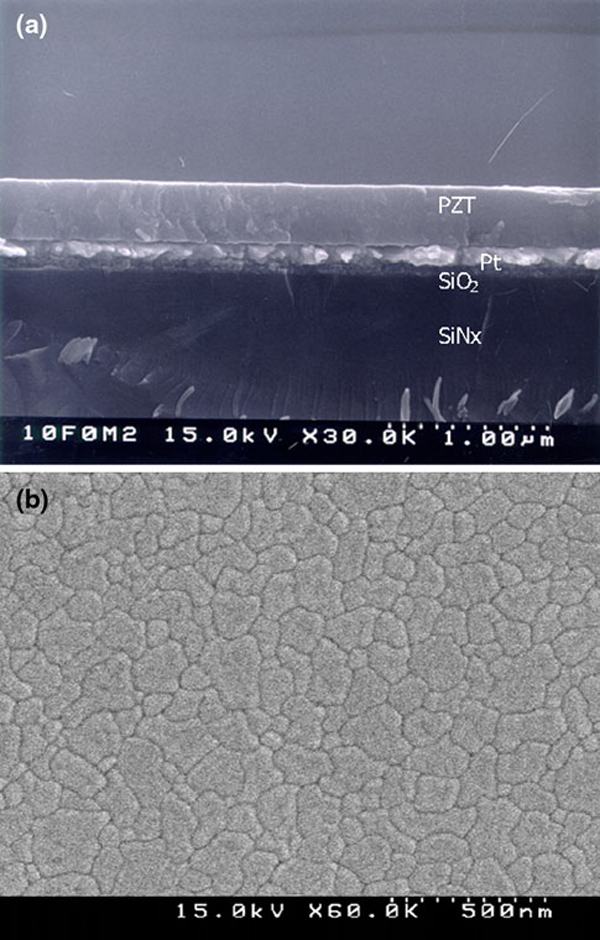
The SEM images of a the cross-section and b the surface of the 0.4-μm-thick PZT film on the multilayered Pt/Ta/SiO2/SiNx/Si substrate.